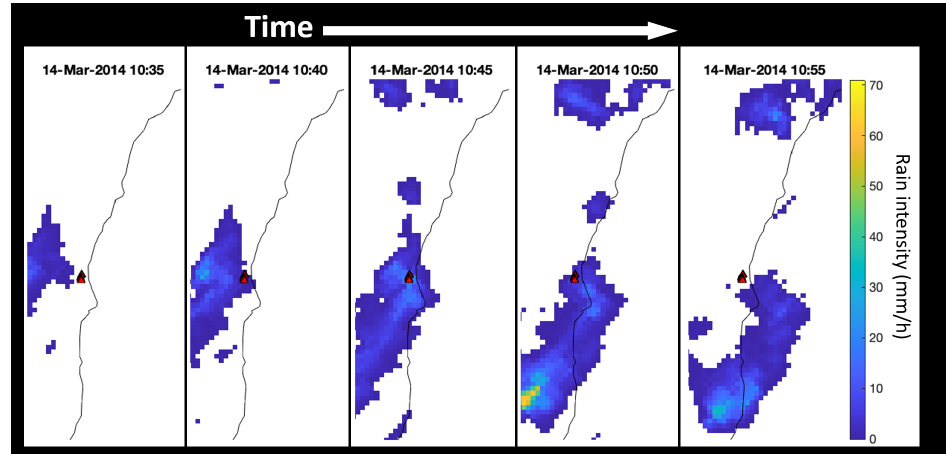
Figure 8. Weather radar maps. Time snapshots (time increases rightward) of the rain intensity over the study area during the time of the triggering cell that triggered group 3 DFs (red triangles). A black line marks the Dead Sea shoreline. The highest rain intensities overlap the group DFs at 10:45LT (UTC + 2), while the whole event is shorter than 30min.